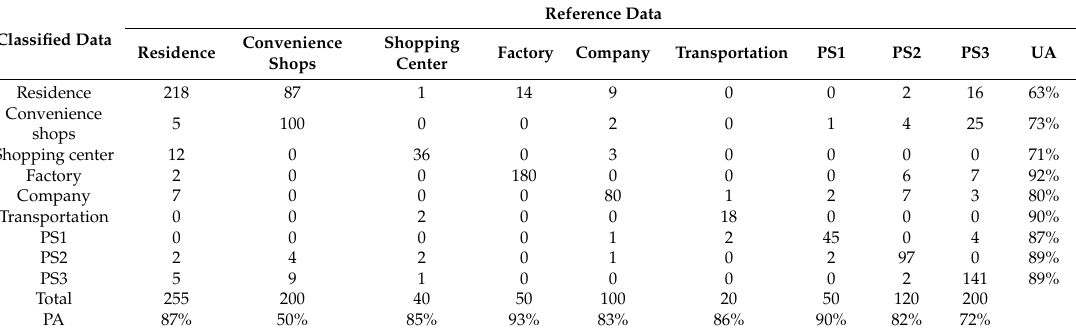
Table 3. The confusion matrix of the urban functional zone extraction. PS1, PS2, and PS3 indicate public service 1, public service 2, and public service 3, respectively. PA and UA refer to the producer and user accuracies of the confusion matrix, respectively.